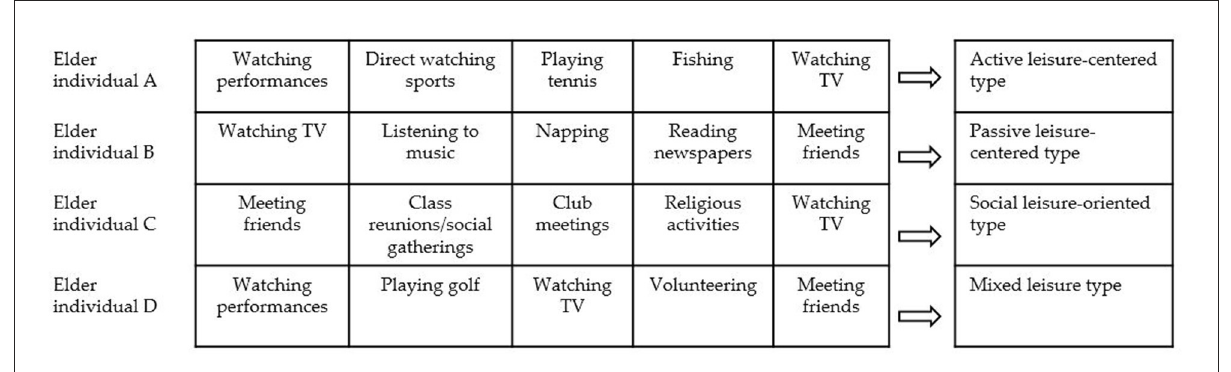
FIGURE1 Conceptual diagram of individual leisure activity